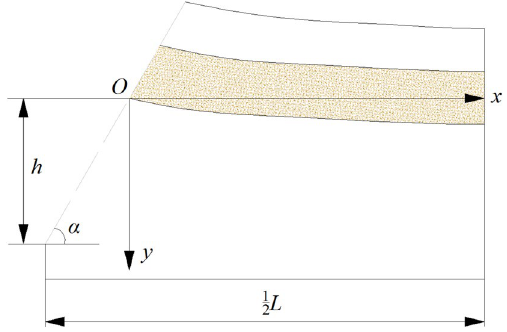
Figure 8. The mechanical model of key stratum in TGZ.